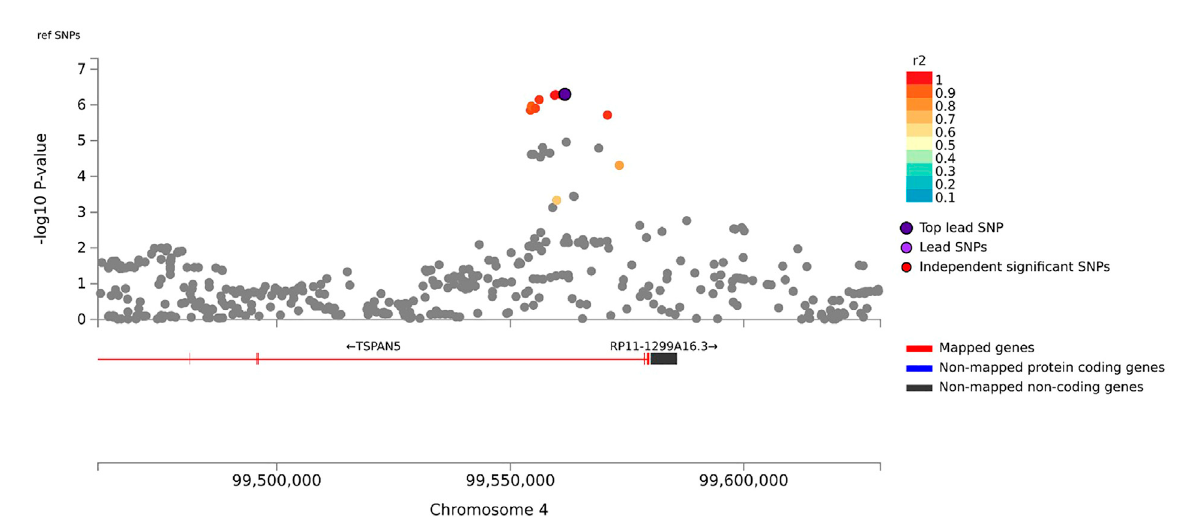
Zoom plot of rs7671702 and its surrounding region on chromosome 4. This variant (purple diamond) is located in the intronic region of the TSPAN5 . p -values on the-log 10 scale are plotted on the left y -axis. The right y -axis indicates the regional recombination rate (cM/Mb), depicted by the blue line in the plot (where peaks indicate recombination hot spots). The chromosomal position is plotted along the x -axis along with the genes located in that region. Variants that are in linkage disequilibrium (r2) with this variant are indicated by colored dots (where different colors represent the level of linkage, as stated in the legend in the upper right corner).